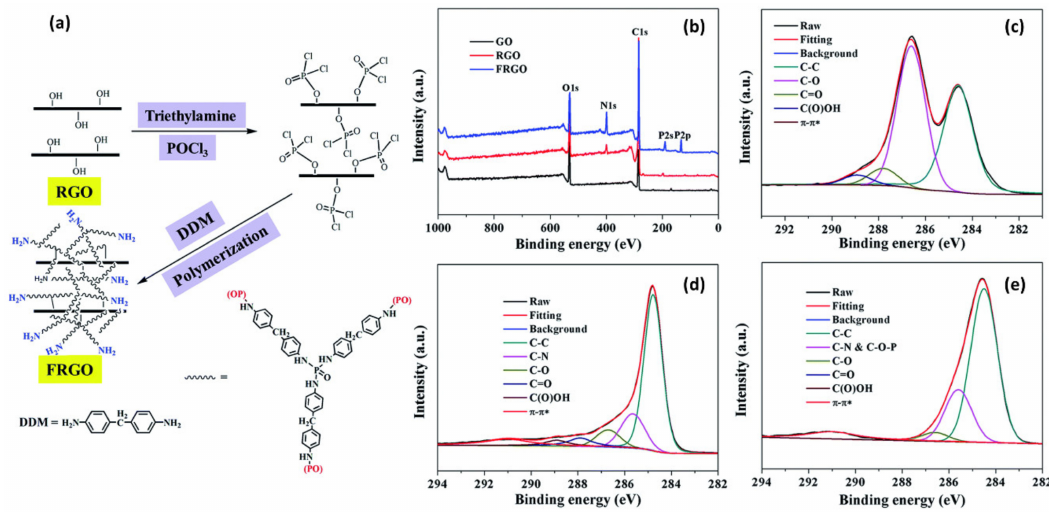
Figure 3. ( a ) Preparation of functionalized reduced graphene oxide (FRGO) nanocomposites. ( b ) XPS survey spectra of graphene oxide (GO), reduced graphene oxide (RGO) and FRGO; high resolution C(1s) XPS spectra of ( c ) GO, ( d ) RGO and ( e ) FRGO (Reproduced from Reference [36] with permission from the Royal Society of